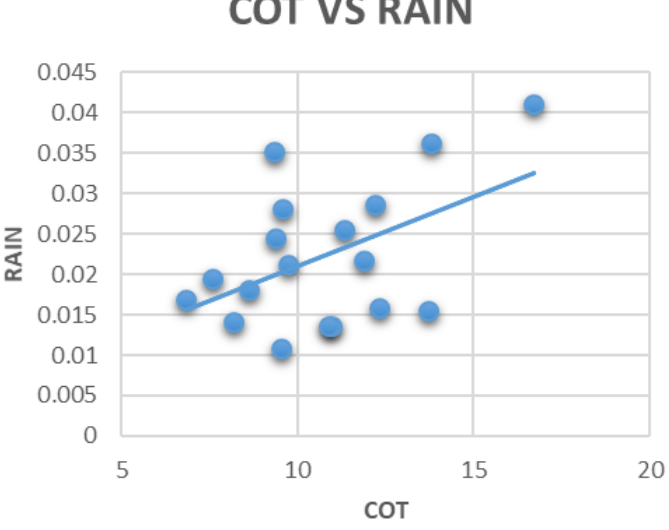
Figure 8. Scatter plot of COT vs. rainfall over Assab in JJA that shows the correlation plot of highlighted bold values given in Table 8.